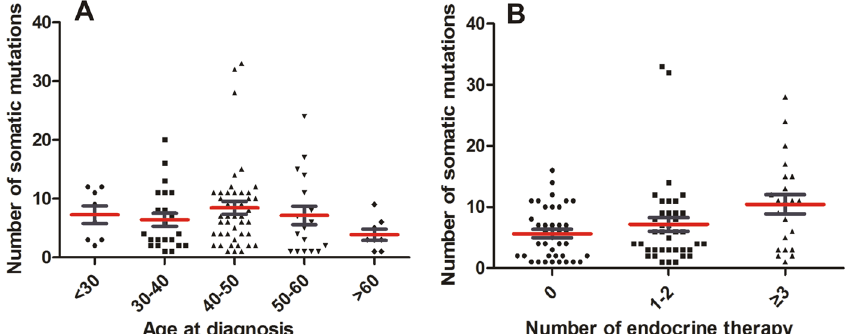
Figure 2. The correlation between the number of somatic mutations and clinical characteristics. ( A ).The relationship between the number of somatic mutations and the age at diagnosis in all 100 patients. ( B ).The correlation between the number of somatic mutations and the line of endocrine therapy in all 100 patients. Dots correspond to number of somatic mutations and whiskers correspond to its Standard Error. Red line correspond to the mean number of somatic mutations.